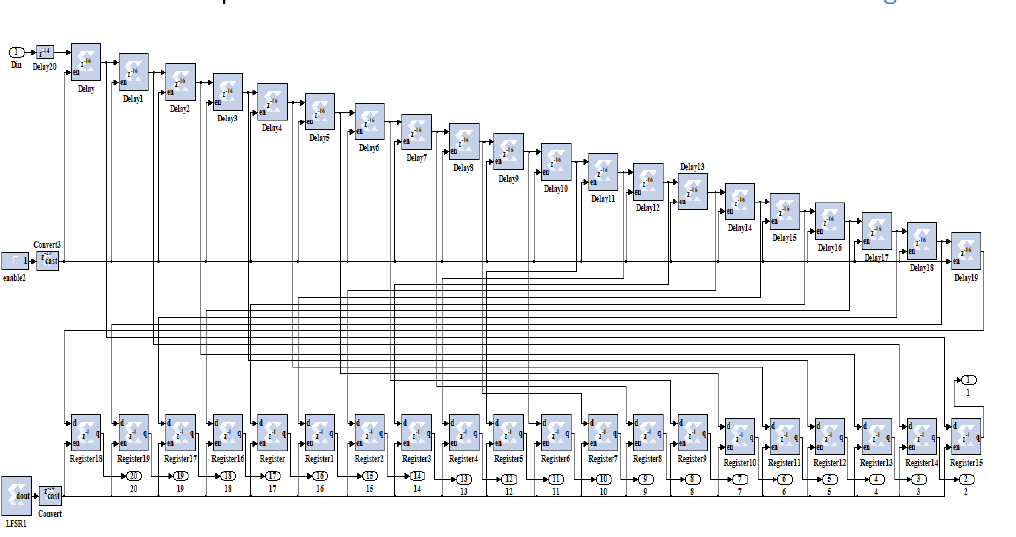
Fig. 10. The Xilinx SG block diagram of 20-sample Serial to Parallel